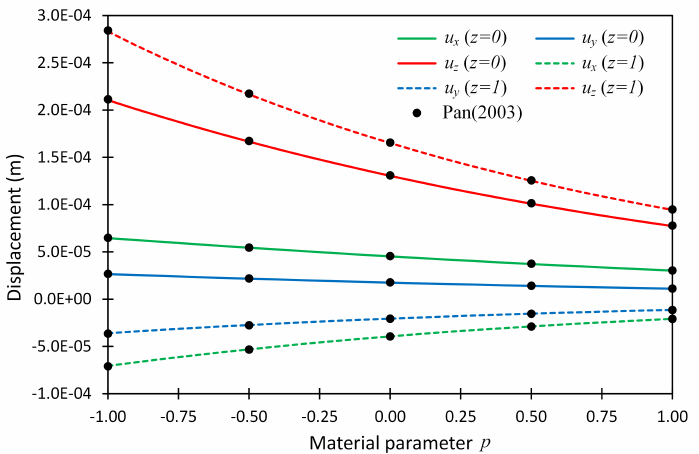
Figure 3. The displacement components at two locations ( x , y , z ) = (0.75,0.75,0) and (0.75,0.75,1) versus material parameter p for Example 1 considering boundary conditions SSSS; the reference solution given in (Pan 2003) [24] is shown by solid dots.